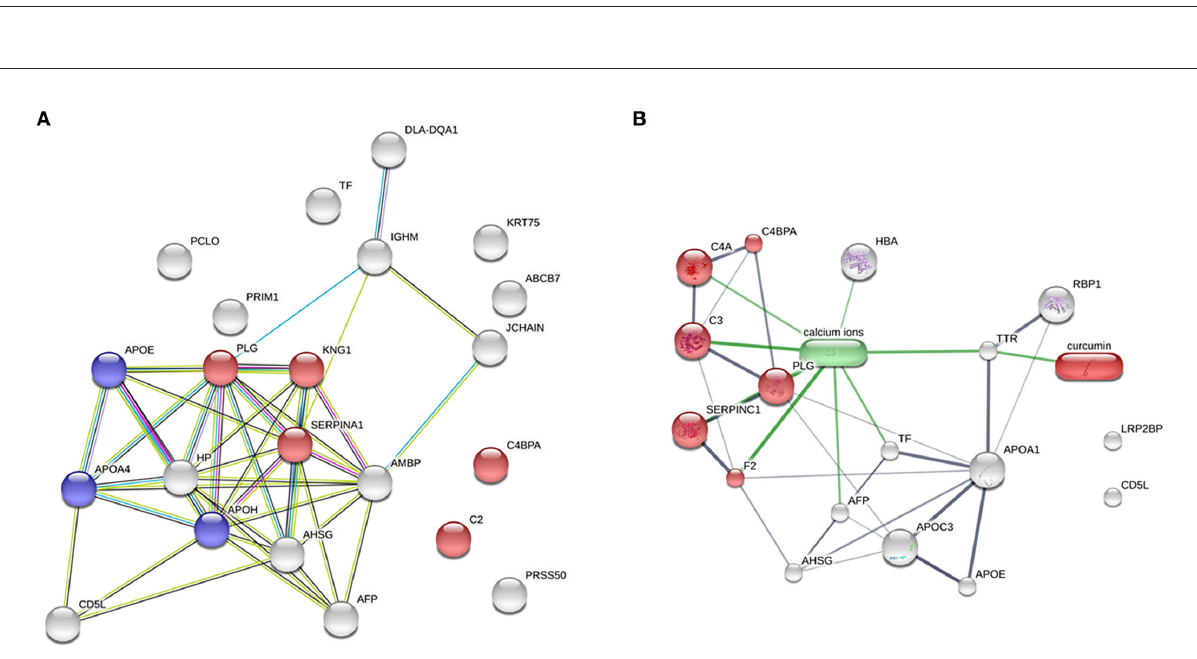
FIGURE4 Network analysis. (A) Analysis of protein–protein interaction between the DM day 0 groups, as compared with the healthy group (total proteins = 22; red = complement and coagulation cascades; blue = cholesterol metabolism). (B) Relationship of curcumin–protein interaction between the DM day 0 group, as compared with the DM day 180 group (red = complement and coagulation